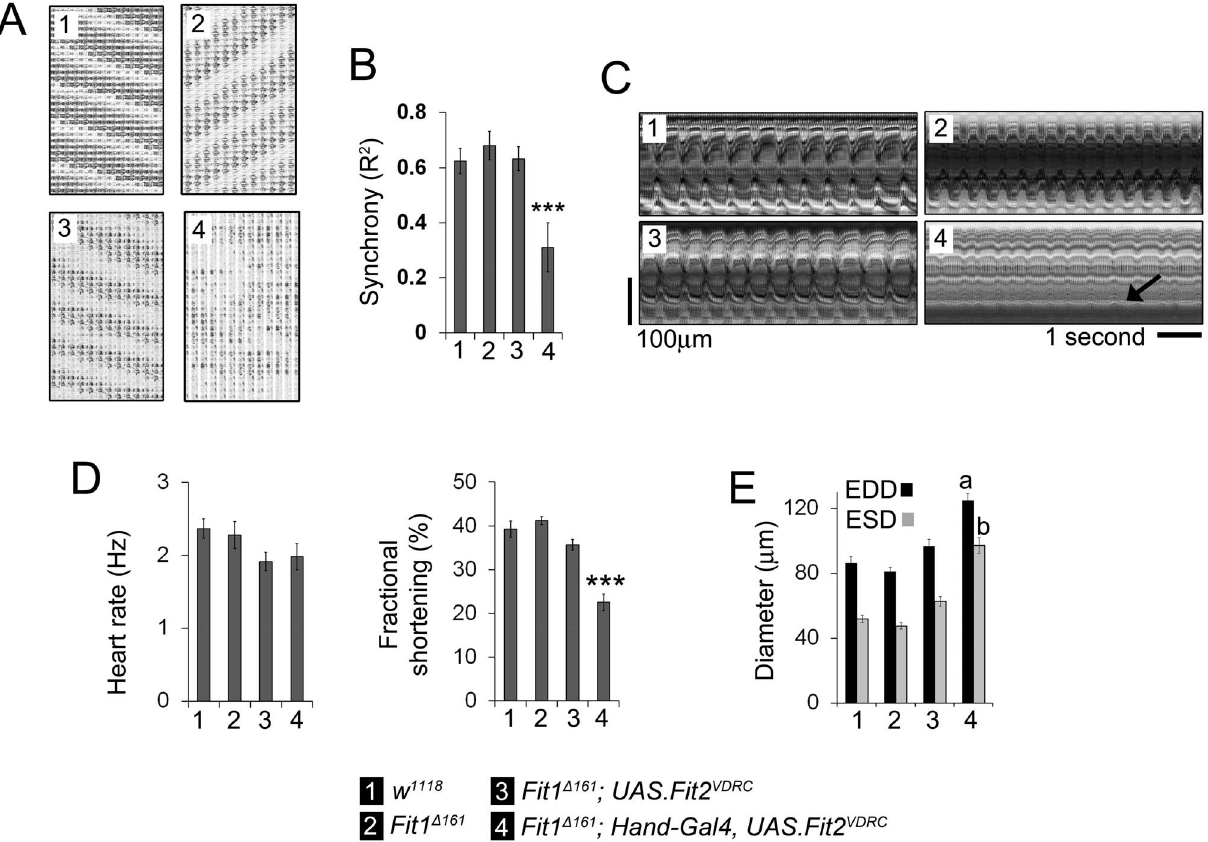
Figure 6. Cardiomyocyte Fit2 compensates for loss of Fit1 to maintain cardiac synchrony and contractility. ( A ) Representative cardiac actograms from four different genotypes. ( B ) Mean ( 6 SEM) synchrony between different regions of the beating heart. n =7 different flies for each genotype. ***P , 0.01. ( C ) Representative M-modes of beating hearts showing the normal contractions in the Fit1 D 161 mutant flies and shallow contractions in the Fit1 D 161 mutant flies when Fit2 is silenced (arrow). ( D ) Quantification of heart rate and fractional shortening in the four genotypes